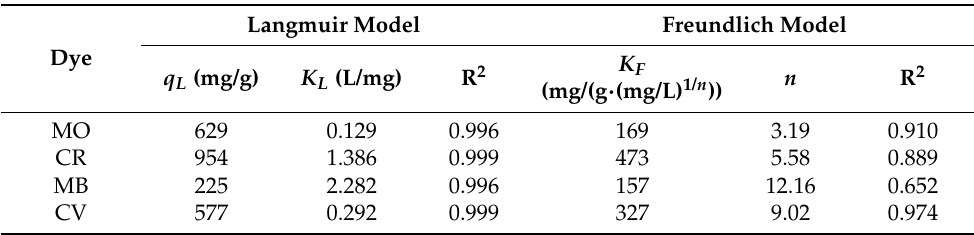
Figure 16. Adsorption isotherms of anionic and cationic dyes onto the DA5 sample using the Langmuir model and Freundlich model: ( a ) MO, ( b ) CR, ( c ) MB, and ( d ) CV (dosage = 0.5 g/L, temperature = 301 K). Table 5. Adsorption isotherm constants of the DA5 sample for the adsorption of anionic (MO and CR) and cationic (MB and CV)